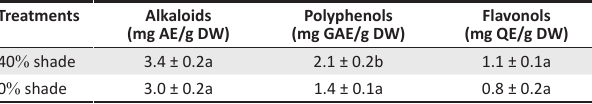
TABLE 1: Content of polyphenols (mg GAE/g DW), flavonols (mg QE/g DW) and alkaloids (mg AE/DW) in aerial part samples of leeks cultivated under different light intensities in the greenhouse